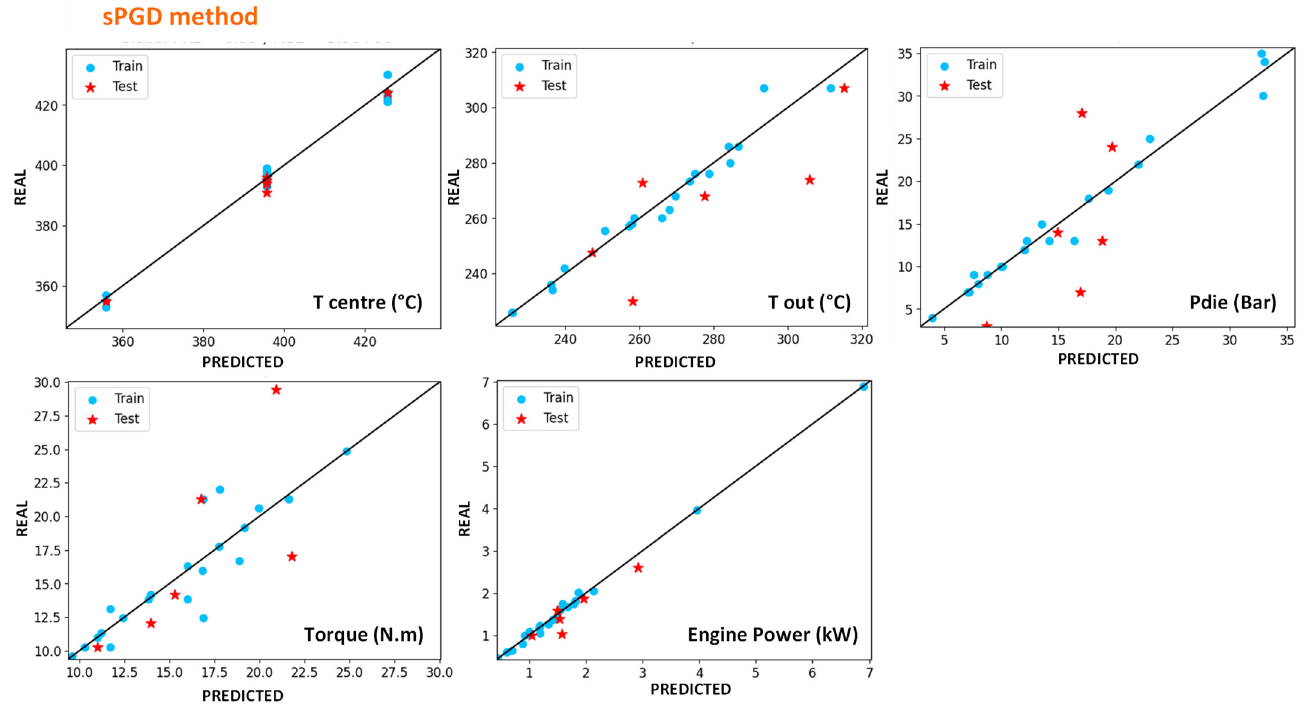
Figure 11. Results of the outputs predicted by the sPGD method versus the experimental ones. The blue dots correspond to training data, and the red stars correspond to test data for HDPE and UHMWPE indiscriminately.